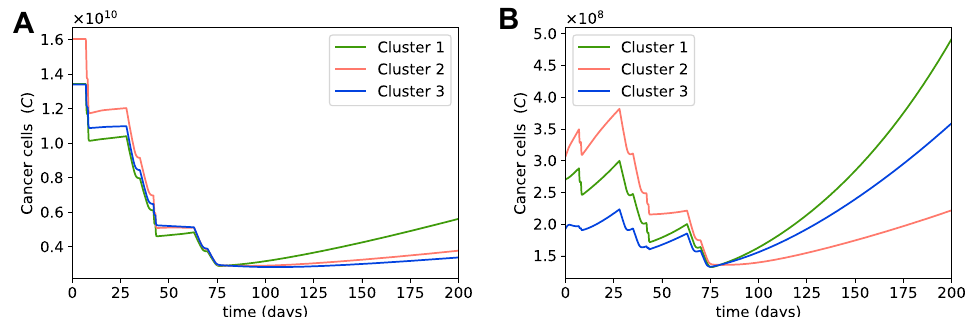
Figure 8. Dynamics with optimal dosages for MAP treatment. Sub-figure ( A ) shows the dynamics of the cancer cell population in a large tumor in each cluster; MAP dosages were optimized to obtain 2.916 × 10 9 cancer cells after treatment. Sub-figure ( B ) shows the dynamics of the cancer cell population in a small tumor in each cluster; MAP dosages were optimized to obtain 1.36 × 10 8 cancer cells after